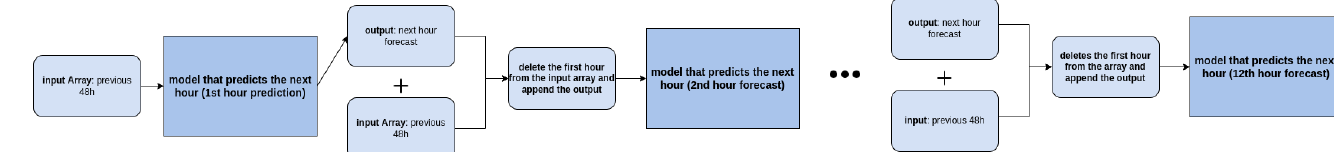
Figure 11. Chained multi-output regression.